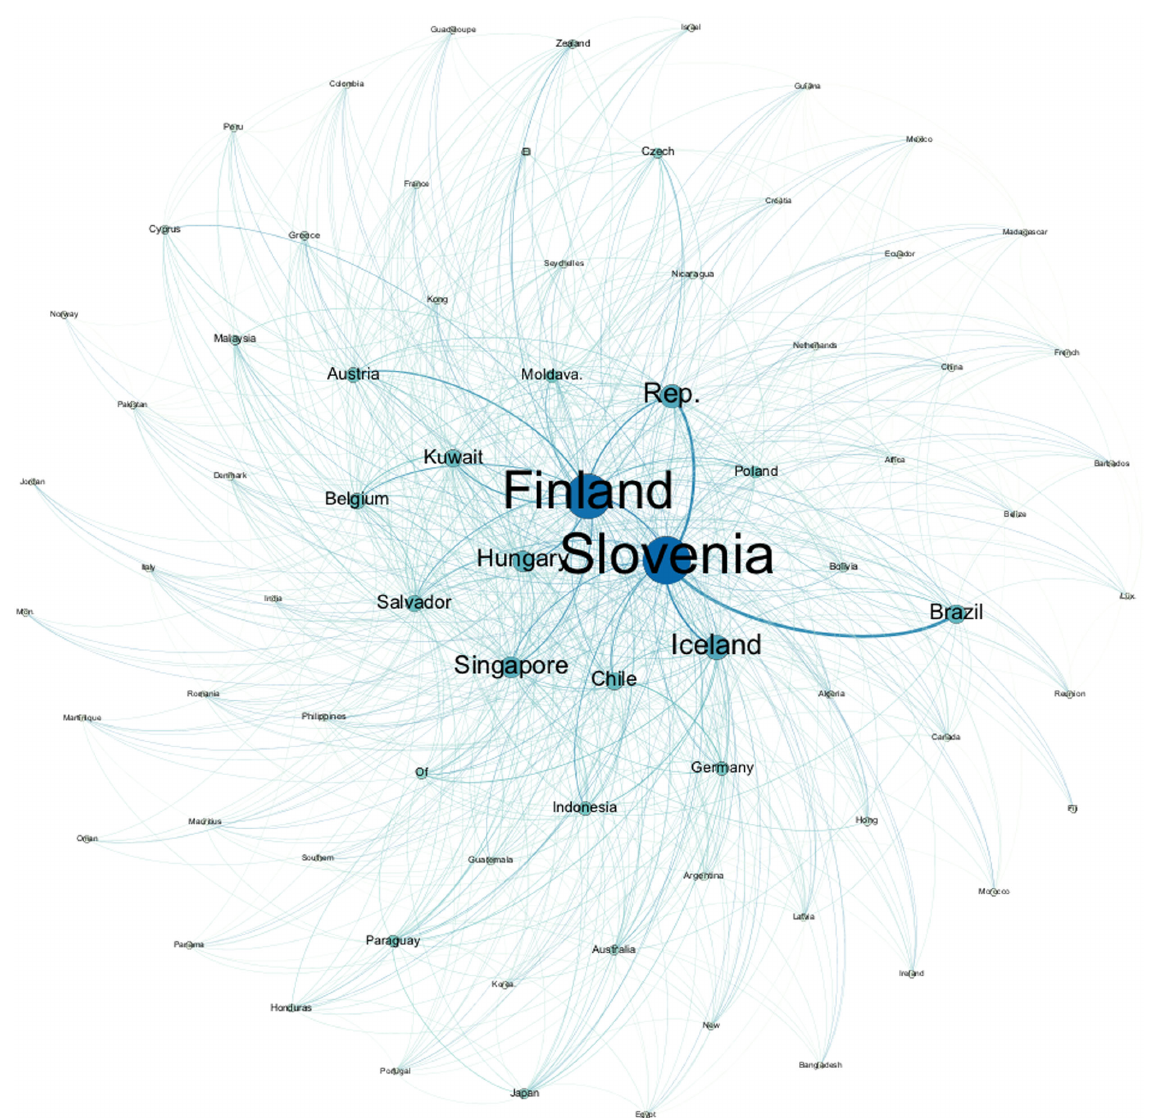
FIG. 10. The 1994 network of world trade in metal. The size of the nodes represents their degree